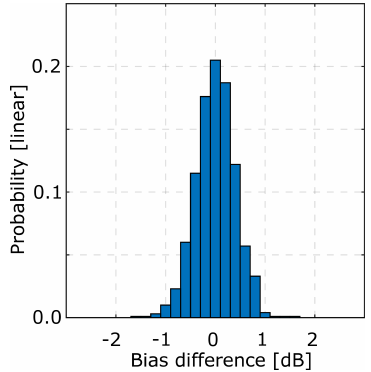
Figure 8. Estimated uncertainty of the reflectivity calibration coef- ficient C Z using the self-consistency method (Sect. 3). Various rain DSDs were used to simulate ideal profiles of radar variables. Ran- dom noise was then added to these profiles and several calibration coefficients before applying the self-consistency method (also see details in the text). The distribution shows the difference between original C Z and the retrieved value. The 5th and 95th percentiles and the standard deviation of the distribution are − 0 . 7, 0.7, and 0.4dB,